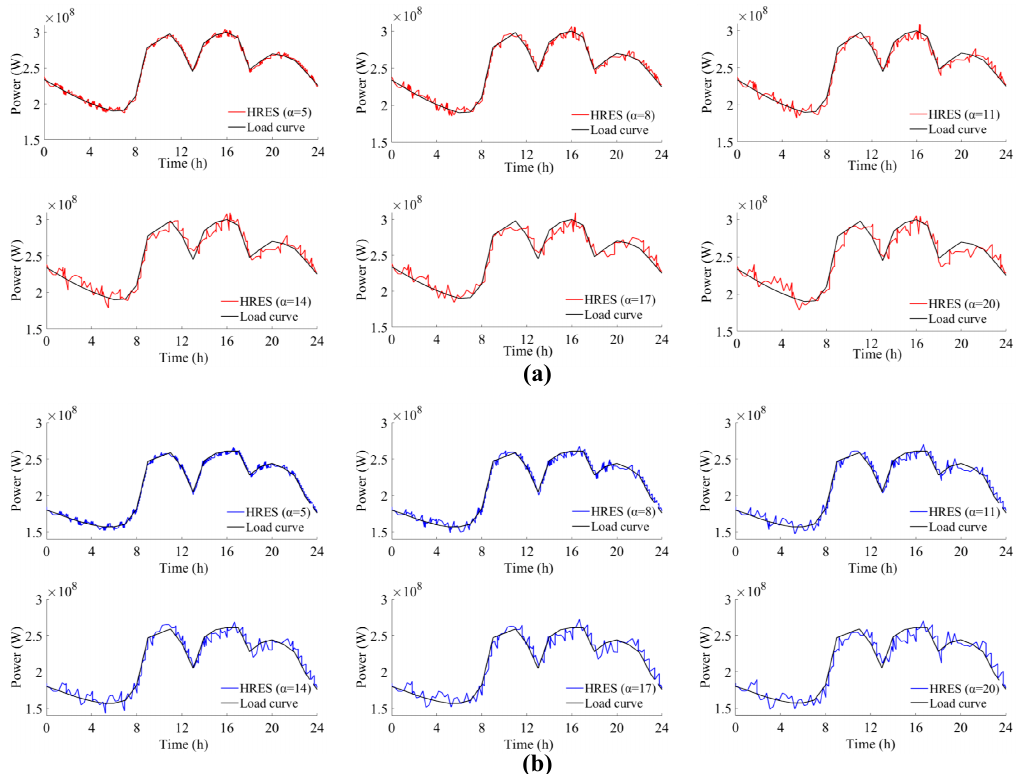
Figure 11. Deduced HRES source-load matching output for some α values: ( a ) typical summer day and ( b ) typical winter day.